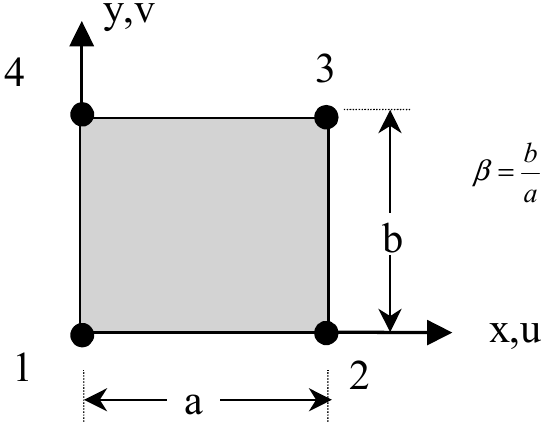
Figure 6. Finite element macro-model dimensions.